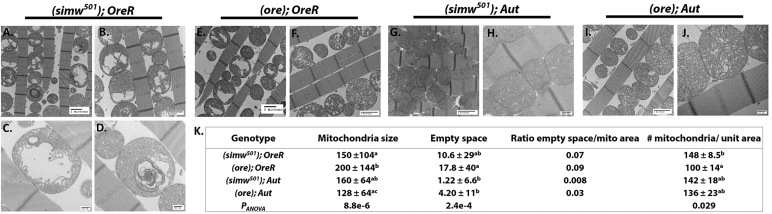
Characterization of mitochondrial morphology in the mito-nuclear introgression strains. TEMs of indirect flight muscle reveal structural abnormalities in (simw501); OreR. (A-D) (simw501); OreR display a loose cristae structure and matrix gaps. (simw501); OreR contained the most mitochondria per unit area, and several examples of swirled concentric cristae structures were observed (A,D). (E,F) (ore); OreR displayed some loose cristae structure and matrix gaps, and on average contained the largest mitochondria. (G-J) (simw501); Aut and (ore); Aut displayed tight cristae packing and healthy mitochondrial morphology. (K) Quantification of mitochondrial morphology parameters in mito-nuclear introgression strains. Approximately 100 mitochondria per genotype were analyzed to generate size data. Different superscript letters signify significant differences in pairwise comparisons (values for PTukey pairwise contrasts are displayed in supplementary material Table S5). Mitochondria were counted in 50 μm×50 μm sections to generate density data. The average number of mitochondria per unit area of >3 sections are displayed. Scale bars: 2 μm (A,B,E-G,I); 500 nm (C,D,H,J).